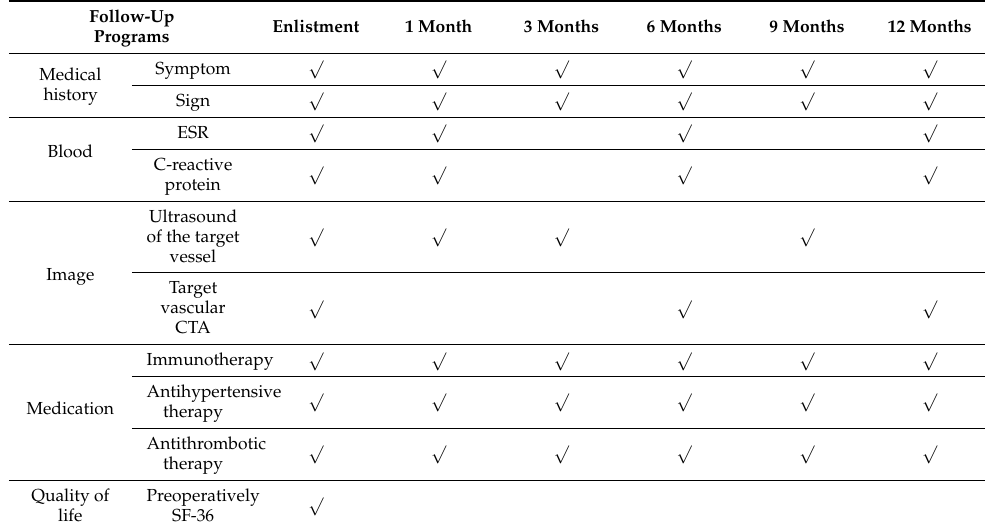
Table 3. Timeline for clinical follow-up information collection for Takayasu